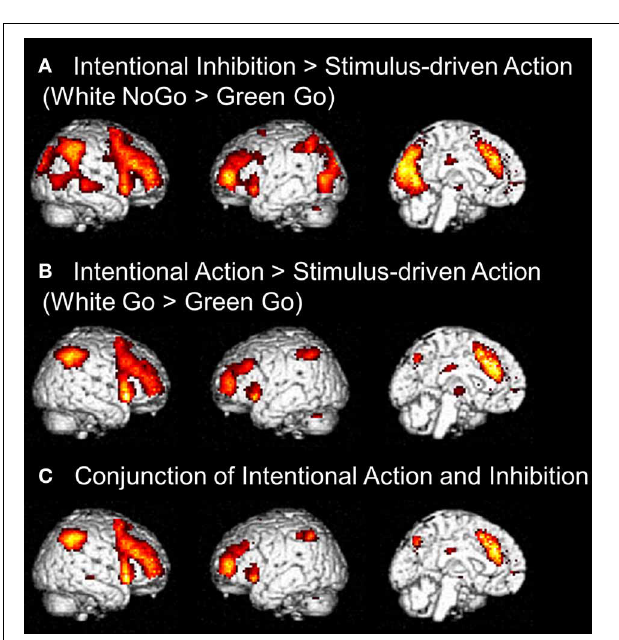
FIGURE 3 | (A) Whole brain contrasts showing activation related to intentional inhibition decision process (White NoGo > Green Go) (FDR-corrected p < 0 . 05, at least 10 contiguous voxels). (B) Whole brain contrasts showing activation related to intentional action decision process (White Go > Green Go) (FDR-corrected p < 0 . 05, at least 10 contiguous voxels). (C) Conjunction analysis showing overlapping activation in intentional inhibition decision processes (White NoGo > Green Go) and intentional action decision processes (White Go > Green Go) (FDR-corrected p < 0 . 05, at least 10 contiguous